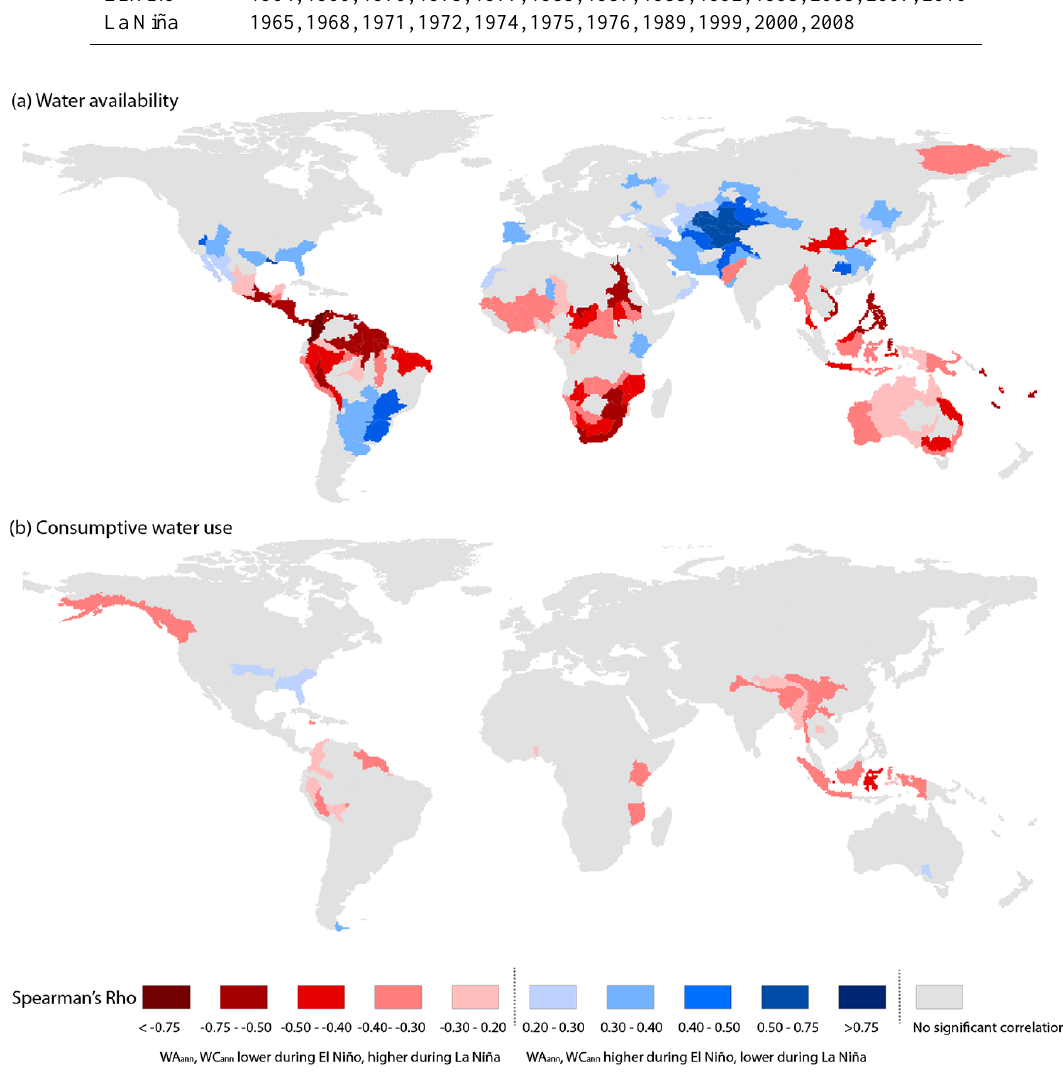
Figure 1. Correlation (Spearman’s Rho) of yearly (a) water availability and (b) consumptive water use values, as assessed under fixed socioeconomic conditions, to variations in JMA SST using the 3-monthly period with the highest correlation (JMA SST bestoff ). Significance was tested by means of regular bootstrapping ( n = 1000, p ≤ 0.05) and the correlation is only shown for those areas which reach significance. Positive correlations indicate increases in annual water availability and consumption with the JMA SST bestoff index moving towards El Niño values. Negative correlations indicate decreases in annual water availability with the JMA SST bestoff index moving towards El Niño values.